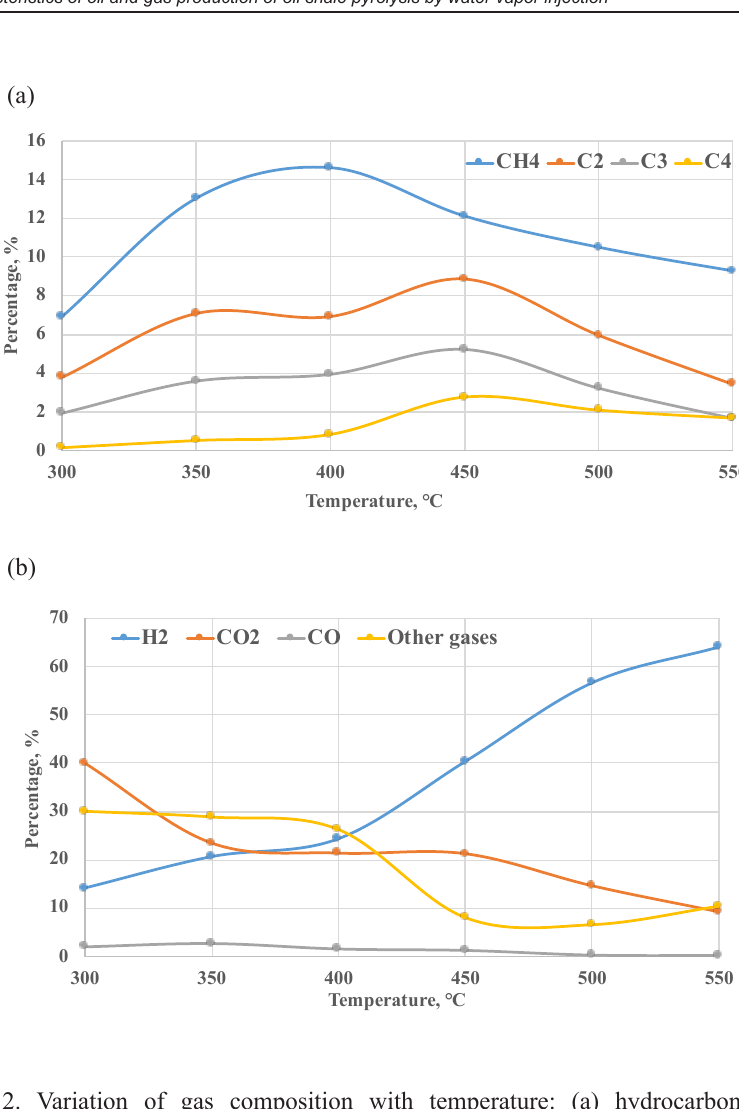
Fig. 2. Variation of gas composition with temperature: (a) hydrocarbon gas; (b) other